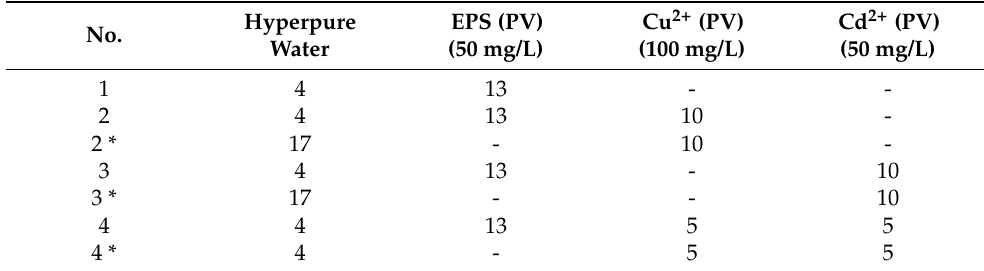
Table 3. Parameter setting of migration